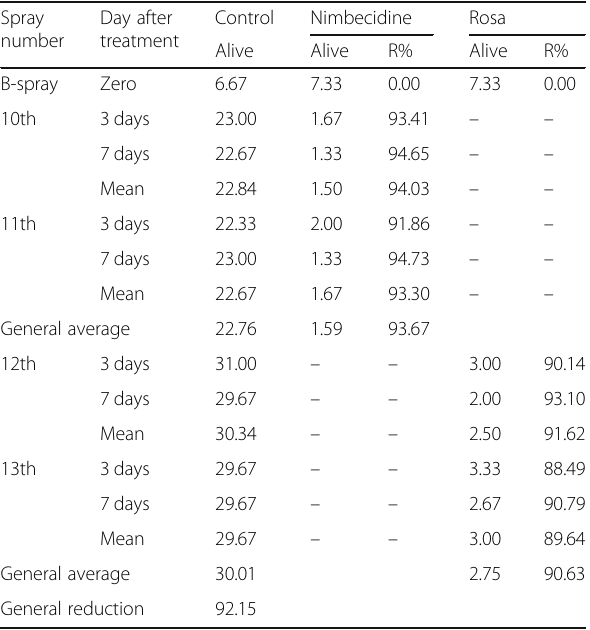
Table 5 Effect of sequential application of certain naturally based formulated compounds on Tuta absoluta applied twice (during fruiting stage) Spray number